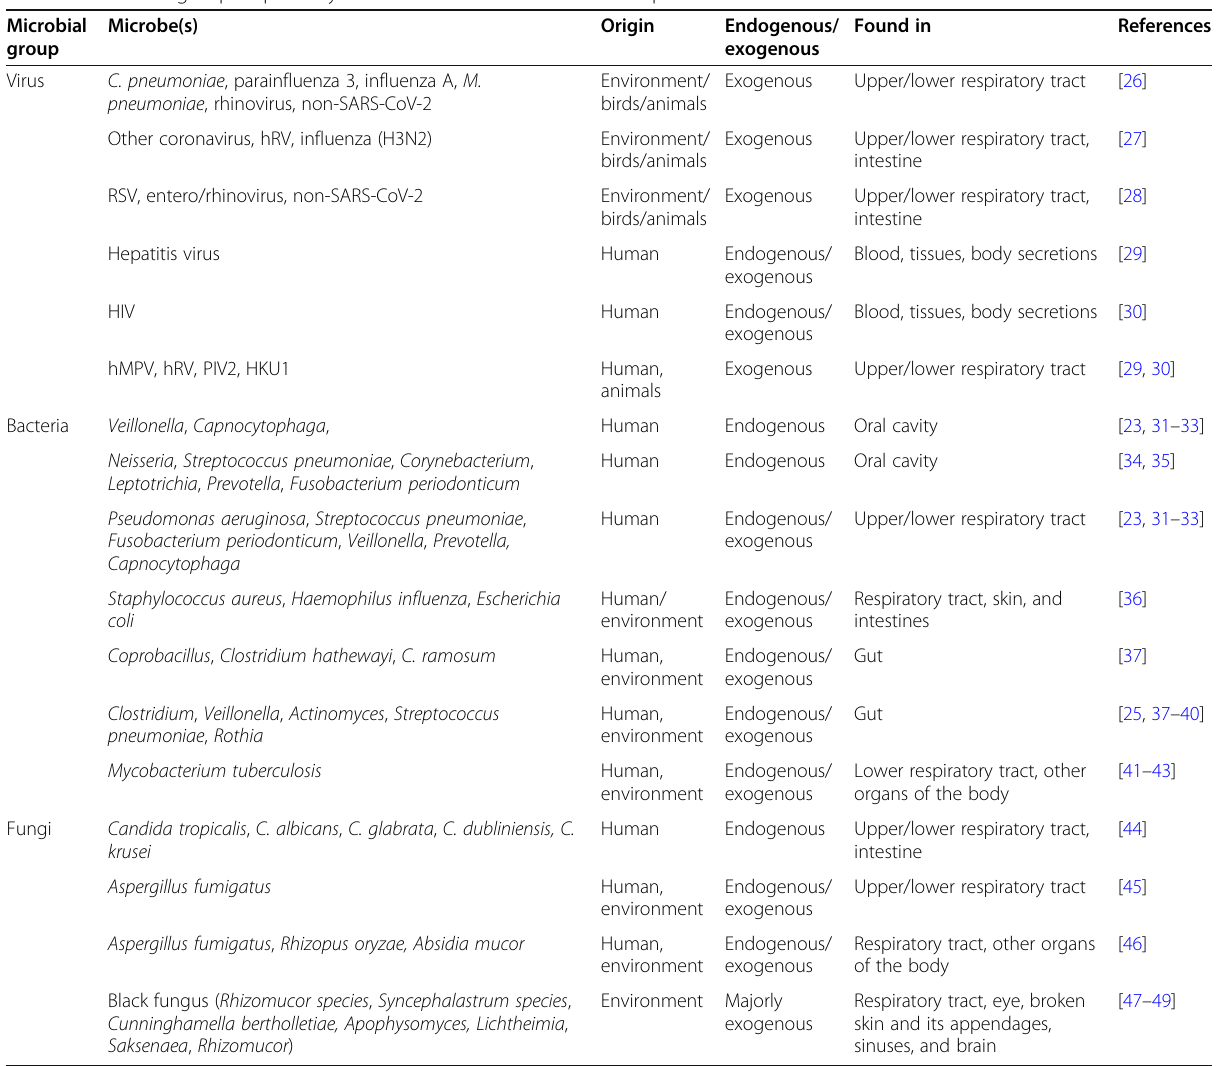
Table 1 Microbial groups reportedly active in coinfection of COVID-19 patients Microbial